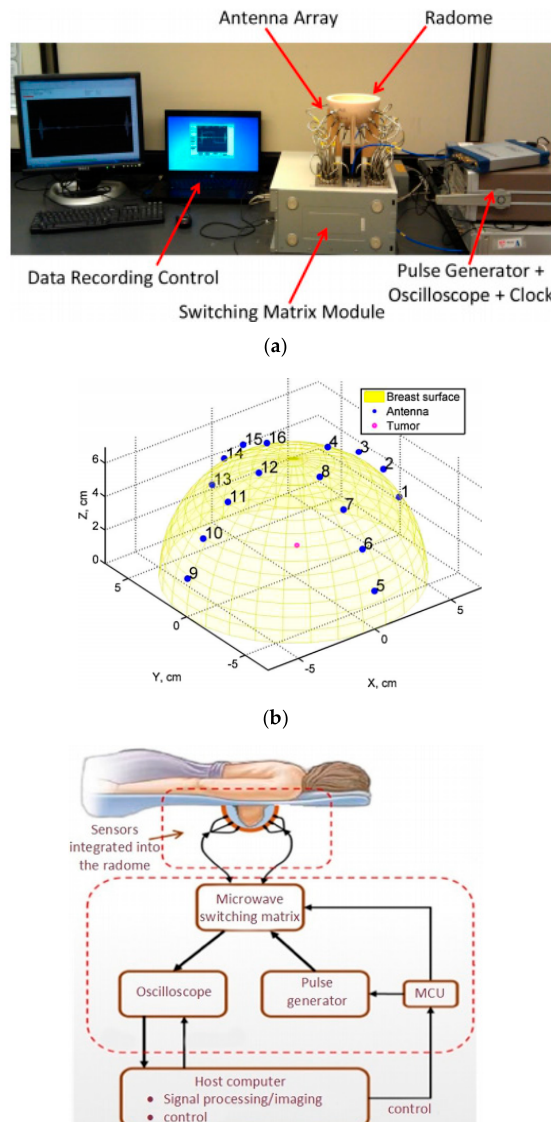
Figure 1. ( a ) Microwave imaging measurement system developed by Li et al.; ( b ) Microwave sensor array configuration; ( c ) Schematic diagram of experiment. Reprinted with copyright permission from Li et al. [106].